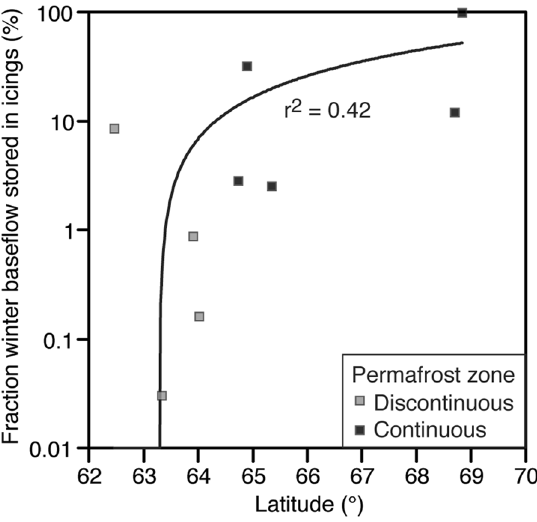
Figure 5. Fraction of winter baseflow stored in icings. The volume of water stored in the icings that is derived from winter baseflow contribution to total annual discharge was calculated for the eight icings (out of the 1402 ones) that have a gauging station along the river. The calculation is corrected for volume of water stored in the icings and assumes icing thickness of 2.5 m. The fraction of winter baseflow stored in icings (Iwb) was calculated